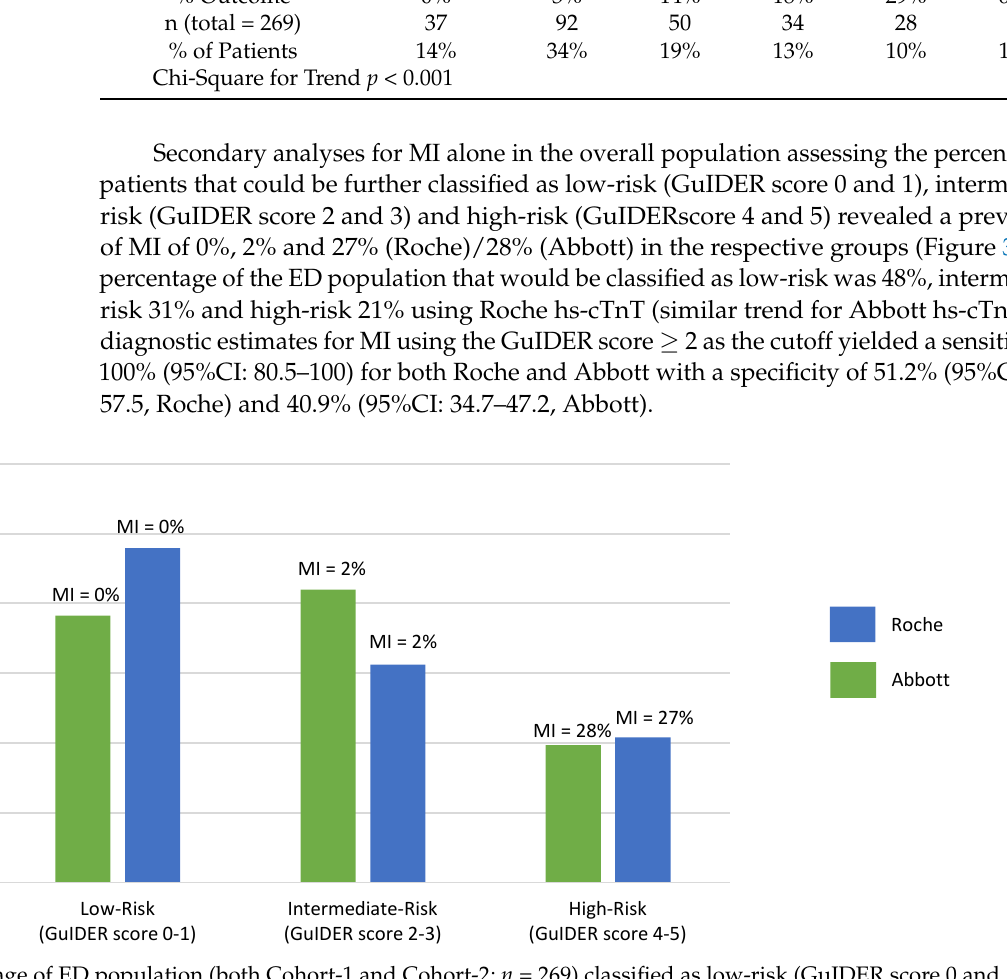
Figure 3. Percentage of ED population (both Cohort-1 and Cohort-2; n = 269) classified as low-risk (GuIDER score 0 and 1), intermediate-risk (GuIDER score 2 and 3) and high-risk (GuIDER score 4 and 5) and the prevalence of MI in these three groups.